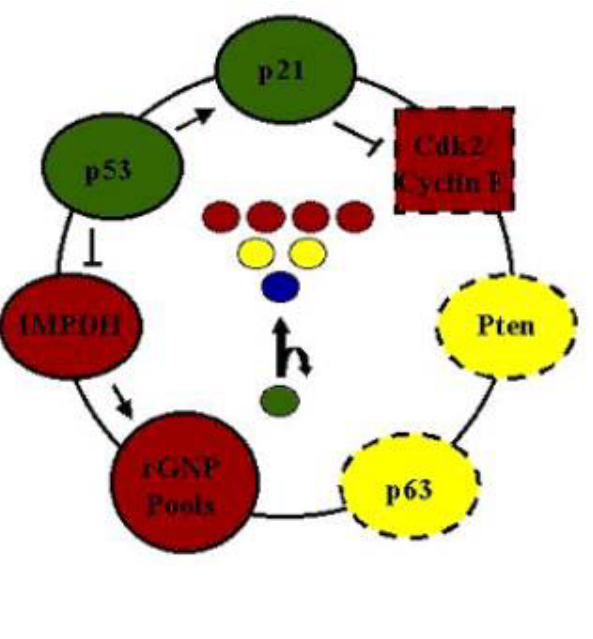
FIGURE 3. Emerging asymmetric cell kinetics genes . Diagrammed are genes implicated in the regulation of asymmetric cell kinetics. For components drawn with solid lines , there is good evidence that their function is rate-determining for asymmetric cell kinetics. Weaker evidence is available for the involvement of components drawn with dotted lines . Expression of green components promotes asymmetric cell kinetics; whereas red components promote symmetric kinetics that may support the exponential expansion of adult stem cells in culture. The nature of possible effects of components in yellow is unclear. P53 may be a central component of a cellular pathway that regulates the cell kinetics of adult stem cells. It simultaneously down-regulates IMPDH expression while up-regulating p21 expression, two events that favor the maintenance of asymmetric cell